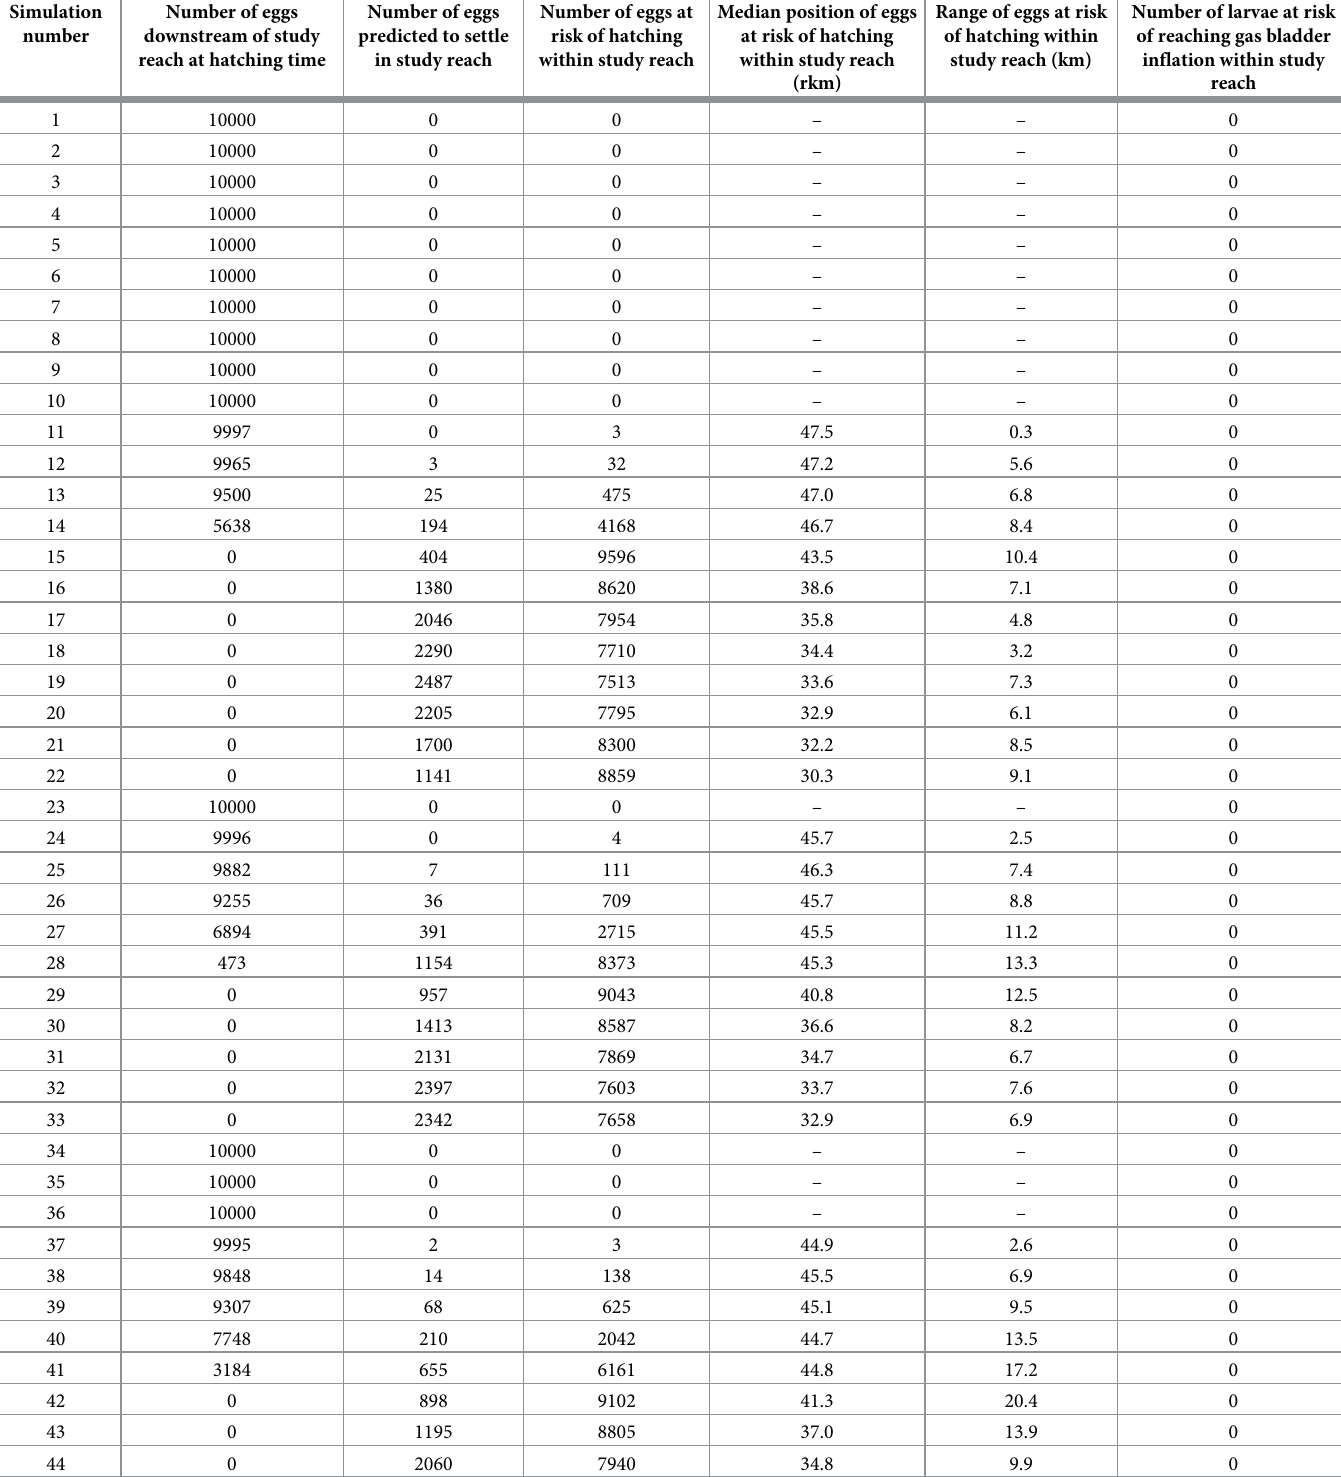
Table 2. Tabular results of FluEgg simulations performed for hypothetical bighead carp spawning in the St. Croix River (Minnesota and Wisconsin). Spawning is assumed to occur in the tailwater of the St. Croix Falls hydropower plant (river kilometer 0.0) in the center of the channel and at the water surface for all simulations.